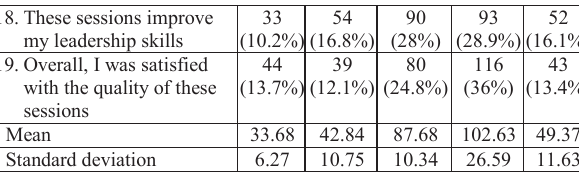
Table-1: Undergraduate Medical student ’s perception about small group discussion sessions at the University College of Medicine, University of Lahore.